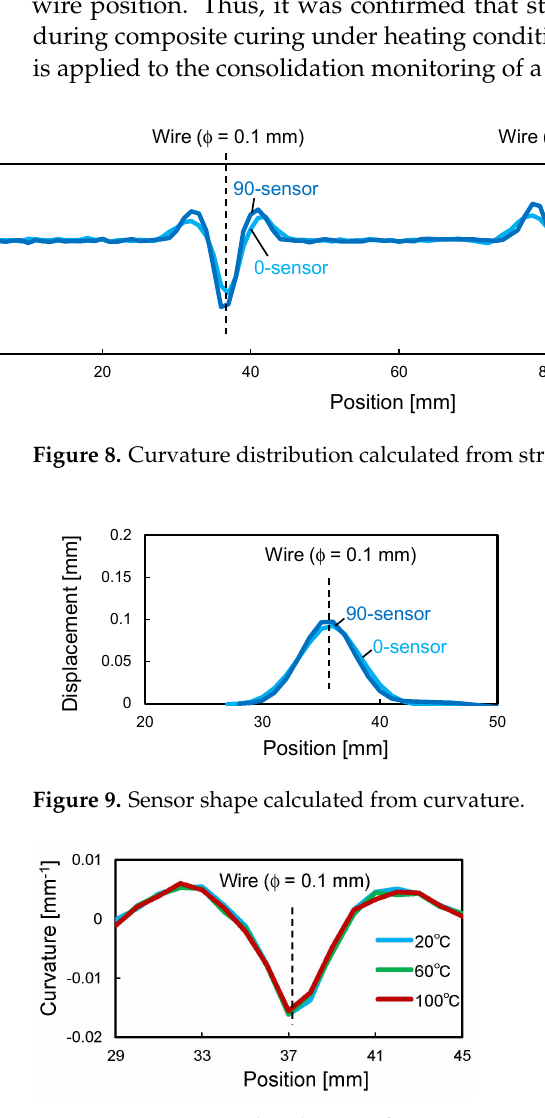
Figure 10. Curvature distribution of 0-sensor at 100 µ m wire position depending on